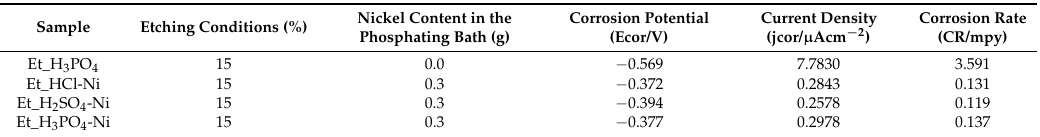
Table 12. The values of corrosion potential, current density, and corrosion rate estimated for samples treated in the phosphating bath containing nickel species.